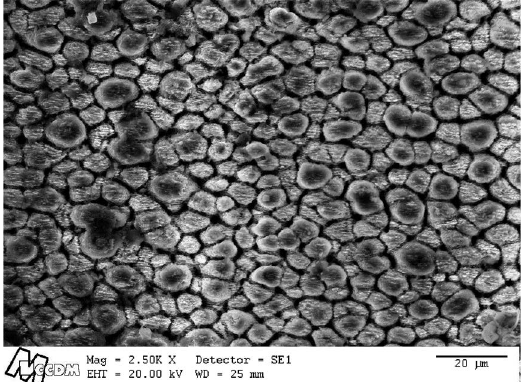
Figure 3. SEM micrograph of the overall appearance of micro- columns formed.